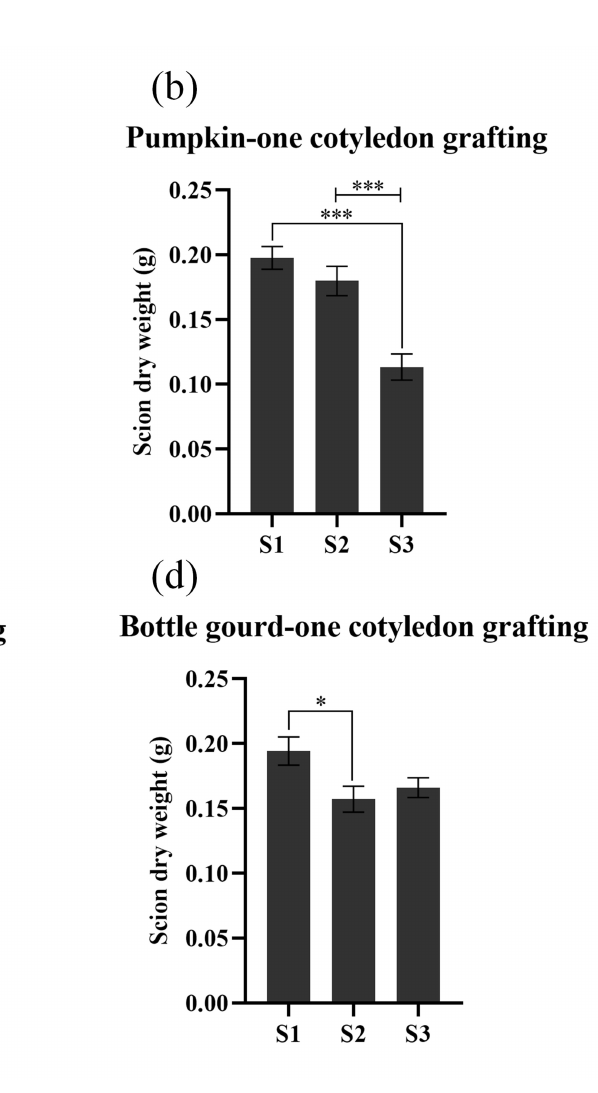
Figure 7. Watermelon scion dry weight at day 14 after grafting ( n = 3). T1 and S1, new “hole insertion grafting” ( a , c ) and “one cotyledon grafting” ( b , d ), respectively, without regrown rootstock removal; T2 and S2, traditional “hole insertion grafting” ( a , c ) and “one cotyledon grafting” ( b , d ), respectively, with manual regrown rootstock removal 3 times; T3 and S3, traditional “hole insertion grafting” ( a , c ) and “one cotyledon grafting” ( b , d ), respectively, without regrown rootstock removal. *, **, and *** indicate significant differences at p < 0.05, 0.01, and 0.001